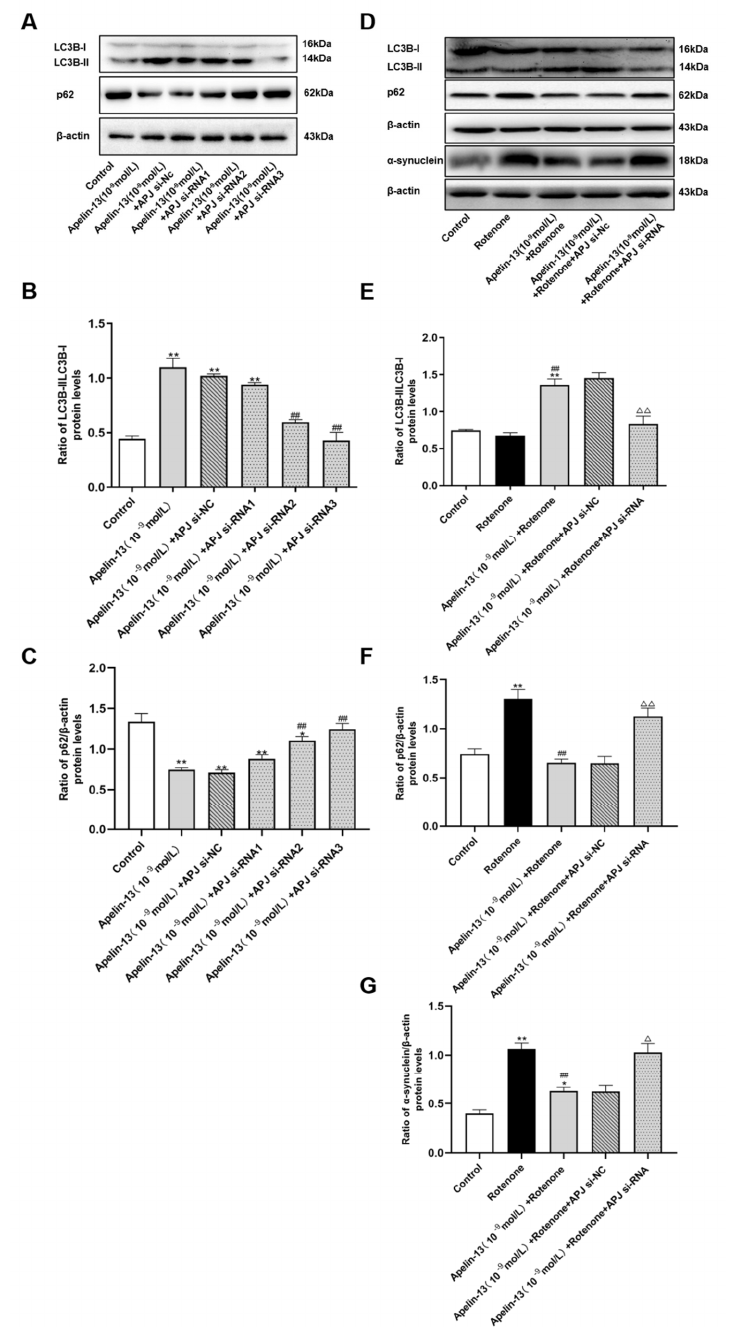
Figure 11. E ff ects of APJ siRNA on autophagy in SH-SY5Y cells with rotenone and apelin-13 treatment. ( A – C ) SH-SY5Y cells were treated with apelin-13 or co-treated with apelin-13 and APJ siRNA. Western blot was applied to detect the phosphorylation of LC3B-II / LC3B-I and p62. APJ siRNA abolished the increased LC3B-II / LC3B-I ratio induced by apelin-13, and restored p62 levels in the SH-SY5Y cells.